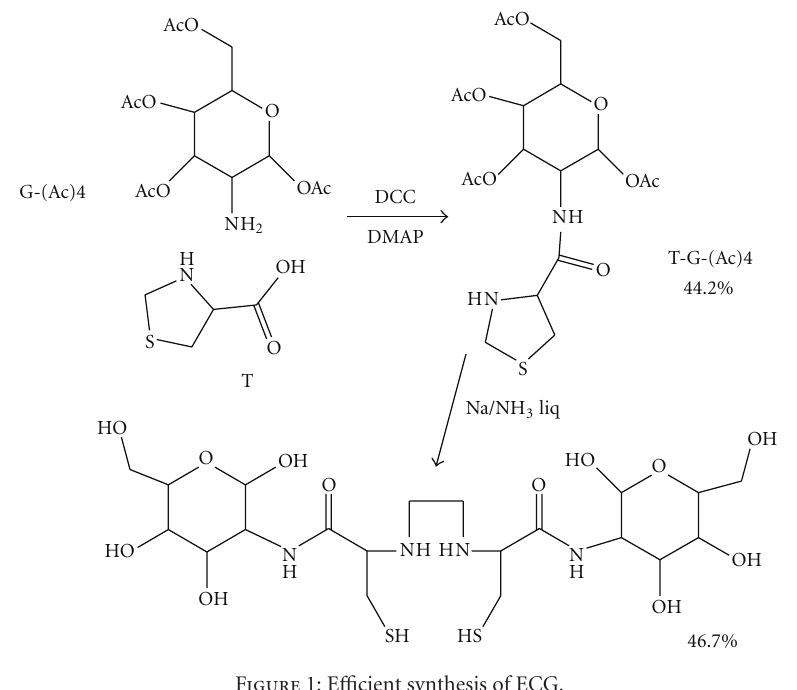
Figure 1: E ffi cient synthesis of ECG.